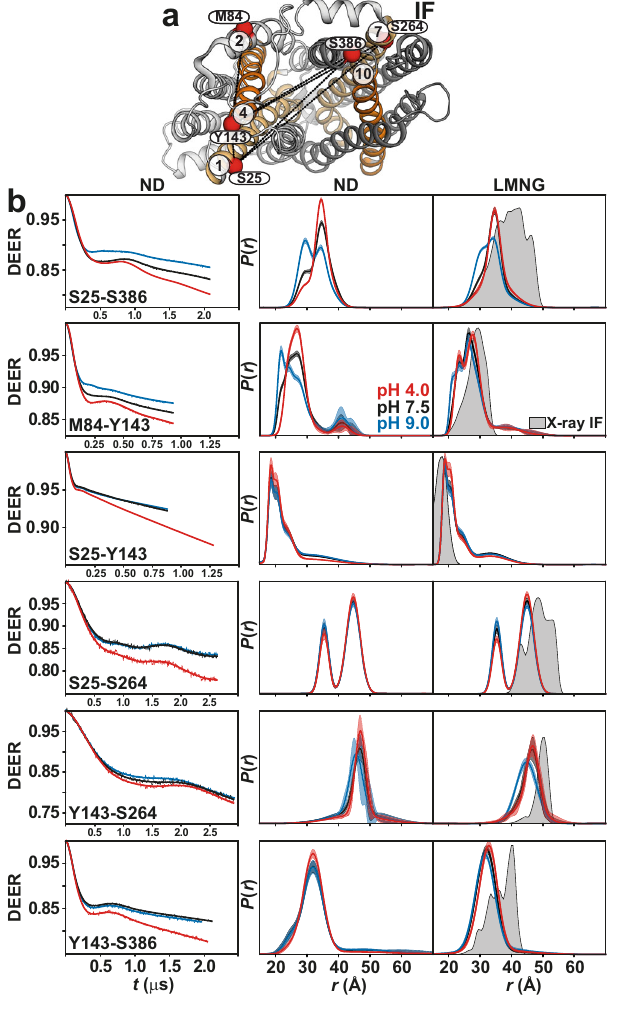
Fig. 3 | Protonation promotes distinct cytoplasmic rearrangements of cavity helices.a Spinlabelpairs(redspheres)reportingonthecavityhelicesaredepicted ontheintracellularsideoftheIFcrystalstructure. b RawDEERdecaysand fi ts(left) arepresentedforthedistancedistributions P ( r )innanodiscs(middle)andinLMNG micelles (right). The distributions predicted from the IF crystal structure are shaded